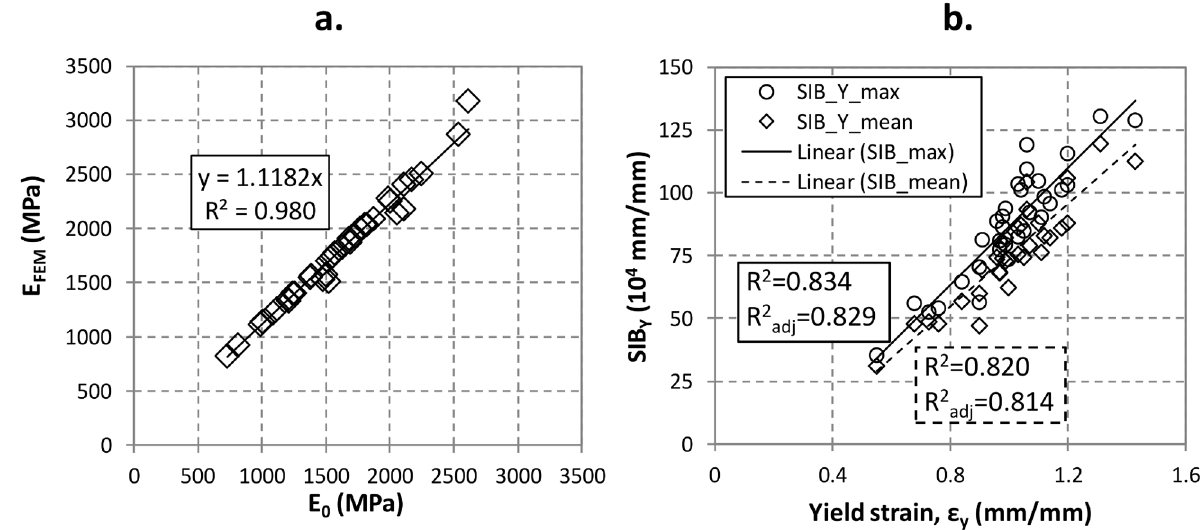
Fig 3. Validation of the numerical procedure: a) Linear correlation between the numerical global stiffness, E stiffness, E 0 . b) Linear correlation between the numerical Yield Strain Index of Bone SIB Y , the and experimental yield strain, ε Y . The linear correlation is shown for both the maximum SIB Y value, SIB yield in each